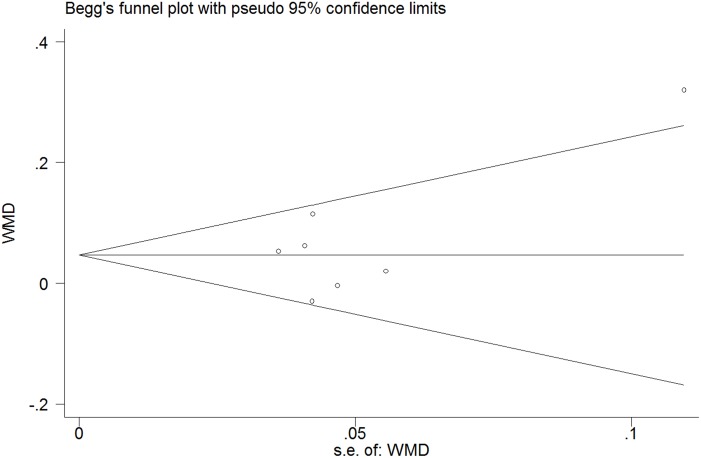
Funnel plots for assessing publication bias of studies included.SE = standard error, WMD = weighted mean difference.